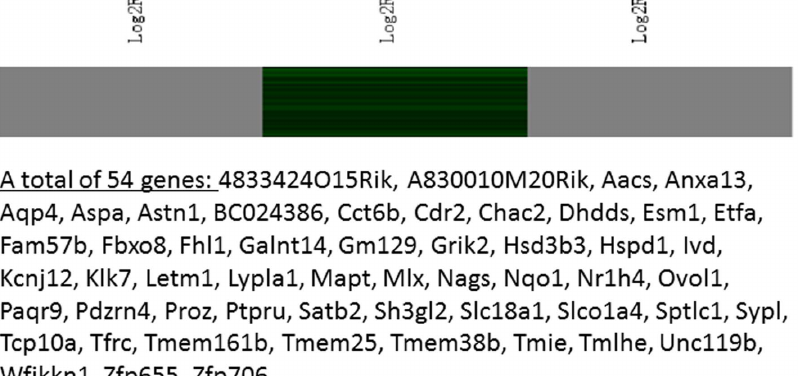
Figure 10. The Heat Map and the list of genes which were down-regulated transiently at the middle stage (8 weeks of age). There were a total of 54 genes in the list.